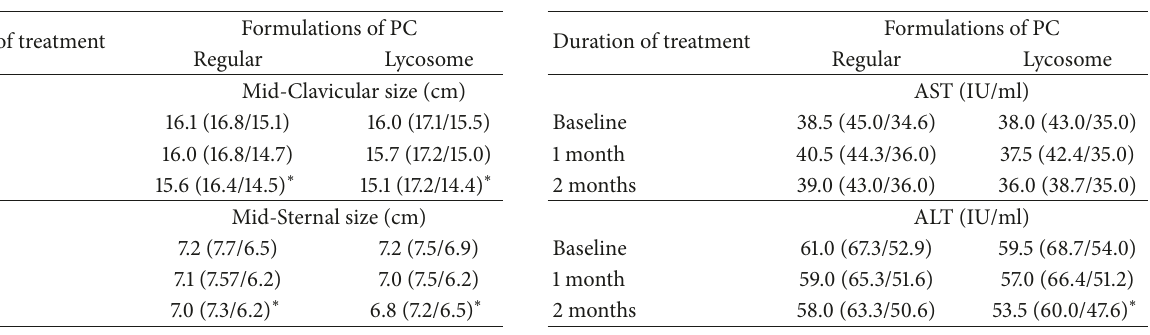
Table 2: Liver span parameters after treatment with regular and lycosome formulations of PC (medians with 95/5%% CI).